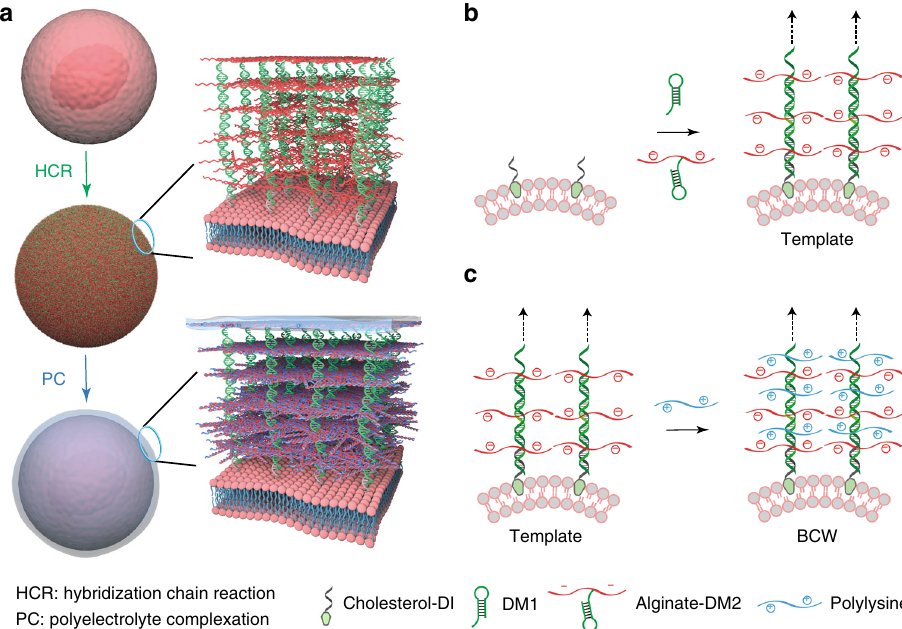
Fig. 1 Schematic illustration of BCW synthesis. a Sequential HCR and PC on the live cell. HCR: hybridization chain reaction. PC: polyelectrolyte complexation. b Formation of the supramolecular DNA template and the concomitant DNA-templated alginate assembly during HCR. Cholesterol- conjugated DNA initiators (i.e., cholesterol-DIs) are inserted into the plasma membrane through cholesterol-lipid interactions. Cells with DNA initiators are incubated in the solution of DM1 and alginate-DM2 for the formation of the template on the plasma membrane. The arrows indicate multiple repeating units. c DNA-templated crosslinking of alginate and polylysine via